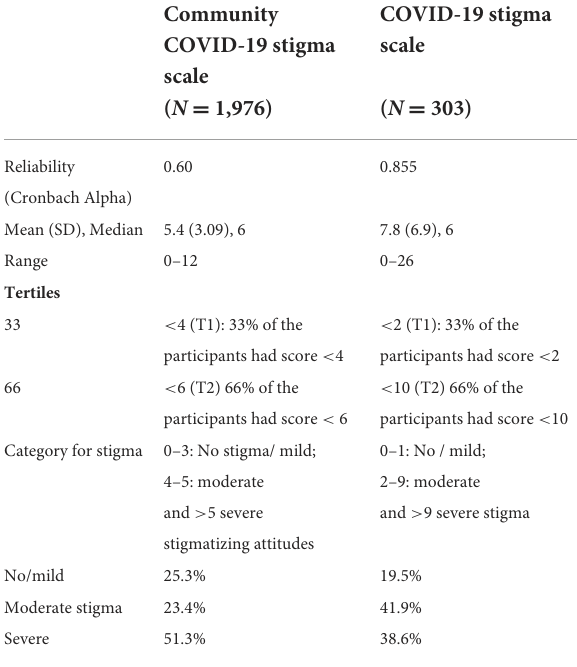
TABLE 1 Community COVID-19 stigma scale and COVID-19 stigma